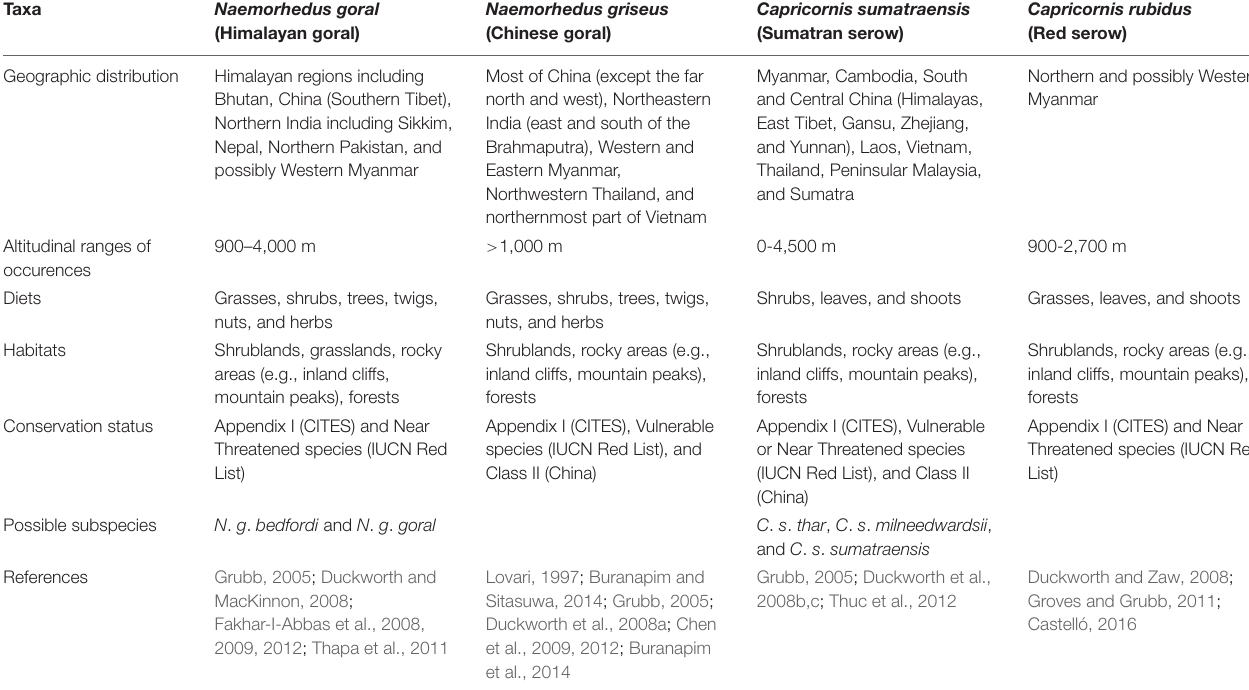
TABLE 1 | Summarized information on geographic distributions, elevation ranges, diets, habitats, and conservation and taxonomic status of extant caprines in Southeast